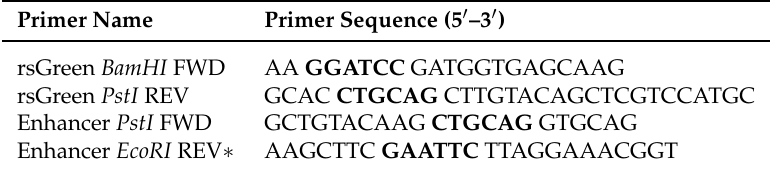
Table 2. List of primer sequences used for amplification and